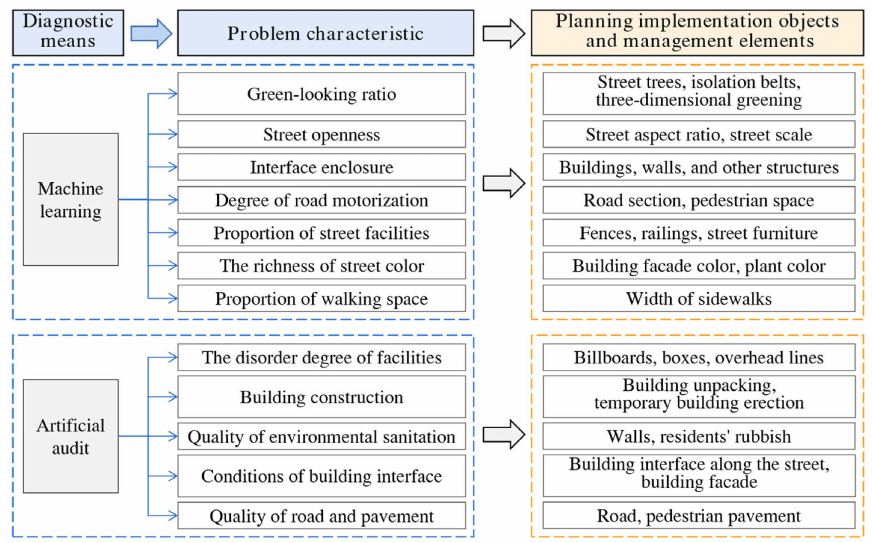
Figure 9. Problem characteristics translated into operational elements of planning